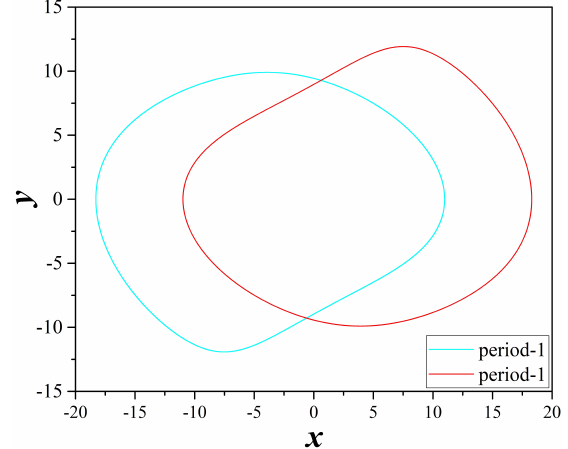
Figure 15. Coexisting attractors of system (2), for a = 4 × 10 − 4 , b = 1, c = 3.846 × 10 − 4 , d = 1 and e = 0.50. With cyan color and for ( x 0 , y 0 , z 0 ) = ( 0,0.1,0 ) a period-1 attractor, while with red color and ( x 0 , y 0 , z 0 ) = ( − 10.969297,0,4.5870237 ) a symmetric period-1